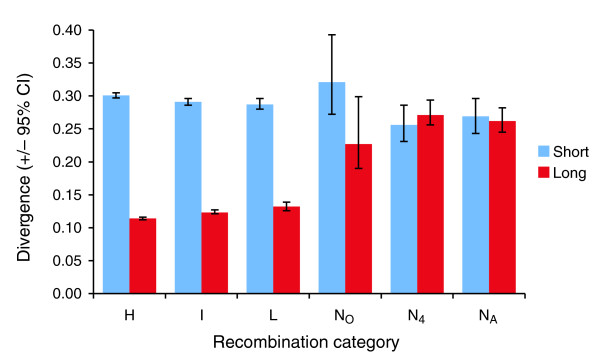
Divergence in short and long introns in each recombination region. Divergence between D. melanogaster and D. yakuba for short introns (≤80 base pairs [bp]) and long introns (>80 bp) for regions of high, intermediate, and low frequency of crossing over, and regions of no crossing over. Values reported are means per site, corrected for multiple hits [50]. Error bars indicate 95% confidence interval (CI) obtained by bootstrapping by intron.